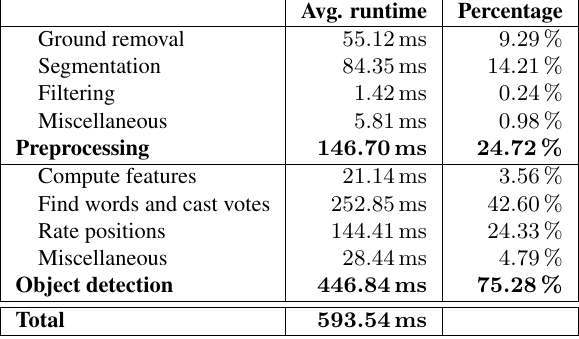
Table 2. Average runtime of each processing step for dictionary of 60000 words and σ of 0.3.